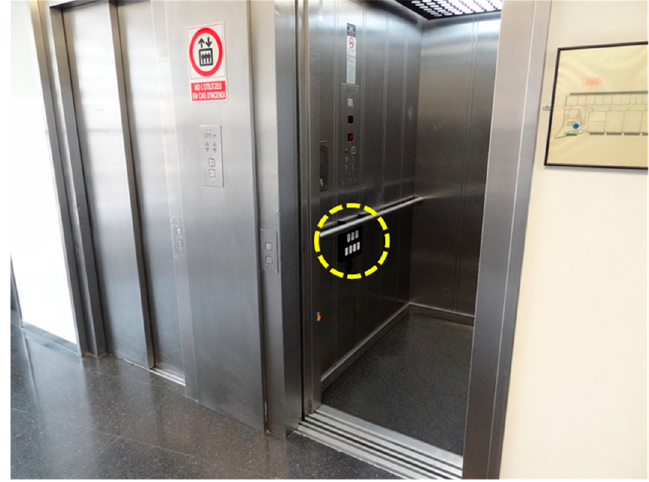
Figure 12. Front view of the right ‐ side elevator (or elevator 1) with the IoT device placed over the lower button panel of the car (yellow circle).